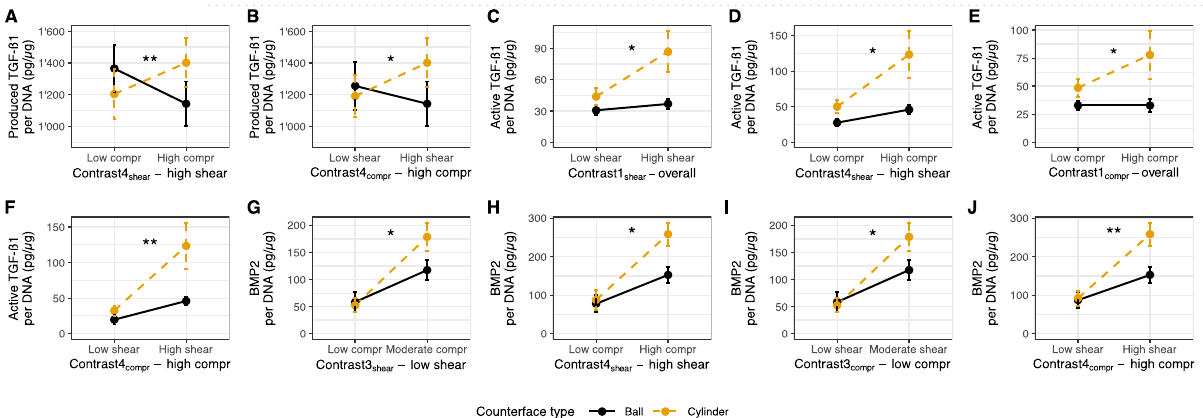
Figure 2. DNA and total sGAG produced (released and retained) content of MSCs seeded in fibrin polyurethane scaffolds and after 10 load cycles.DNA content ( A ) and total sGAG content (sample + medium) ( B ) of MSCs in loaded scaffolds distinguished by counterface type (Ball and Cylinder) or unloaded (UL) condition and loading protocols. Data are shown as mean ± SEM of three independent experiments with cells from three individual donors. Each experimental group was run in technical replicates. Statistical testing was not performed on single conditions but on contrasts (Supp. Fig. 2). s shear, c compression.